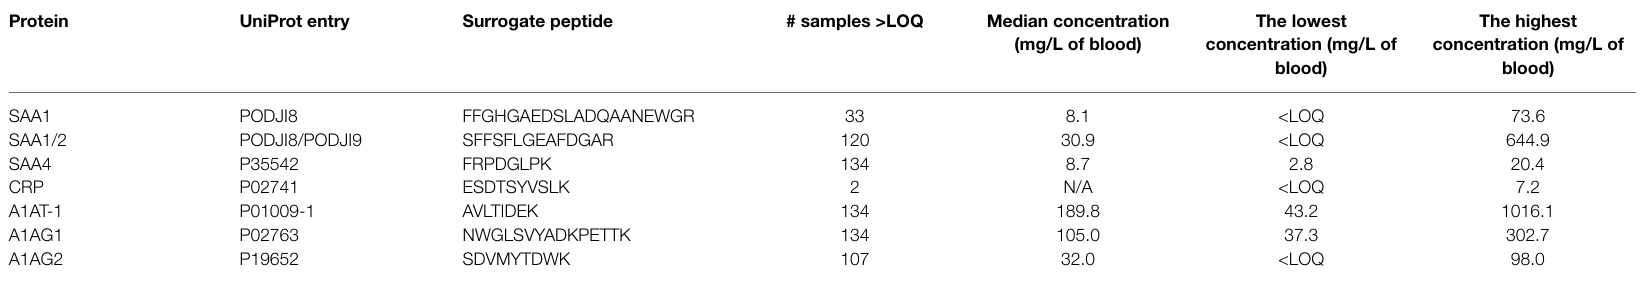
TABLE 2 | The lowest, the highest, and median levels of acute-phase proteins in DBS. Protein UniProt entry Surrogate peptide # samples >LOQ Median concentration